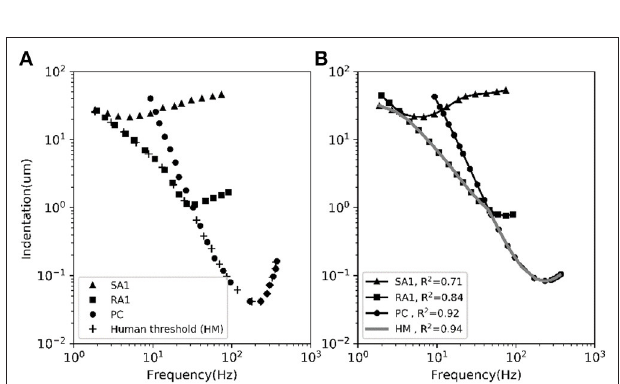
FIGURE 5 | The average frequency-threshold curves of single-unit. (A) Observations [adapted from SA1, RA1 ( Verrillo and Bolanowski Jr, 1986), PC ( Mountcastle et al., 1972), HM (Gescheider et al., 1985)]. (B) Prediction of our model. The human threshold (HM) is the minimum of the thresholds of the 3 mechanoreceptive types. The R2 in the legend is the coefficient of determination between the observed data in panel (A) and the predicted data in panel (B) for each afferent and for the human threshold